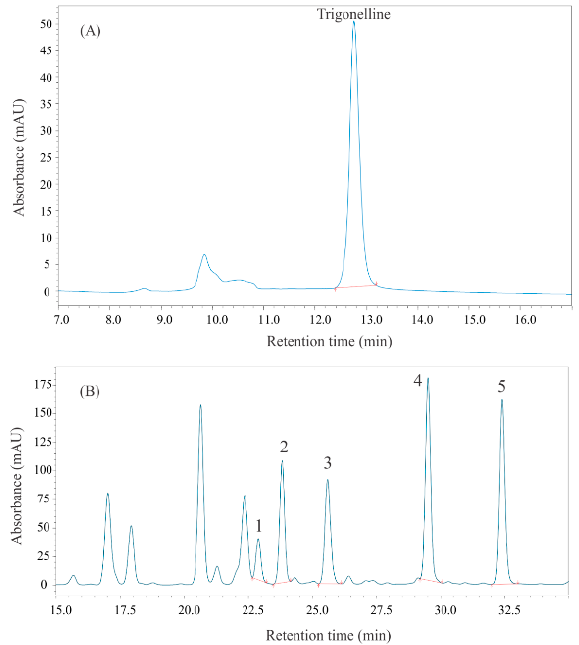
Figure 1. HPLC chromatograms of trigonelline ( A ) and flavonoid compounds ( B ) extracted from a sample of fenugreek seeds. The identified peaks ( B ) are orientin (1), isoorientin (2), vitexin (3), isovitexin (4), rutin as internal standard (5).